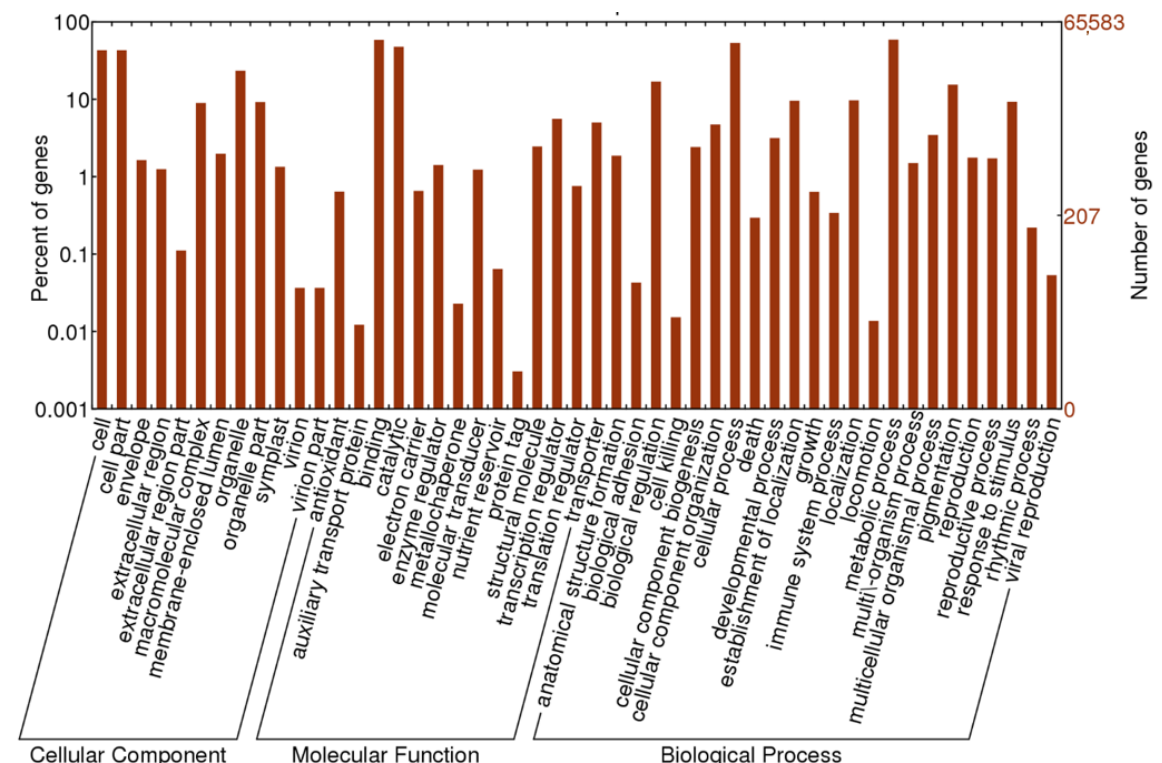
Figure 2. Gene Ontology classification of assembled unigenes in Brassica juncea . The results are summarized in the categories of cellular component, biological process and molecular function. The right Y -axis represents the number of genes and the left Y -axis shows the percentage of total unigenes.